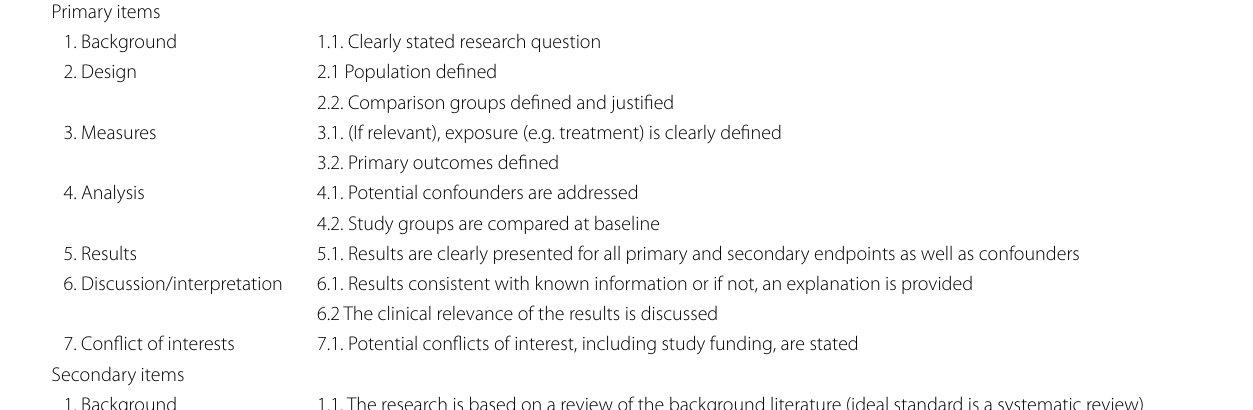
Table 1 RELEVANT REG quality assessment tool for observational research Primary